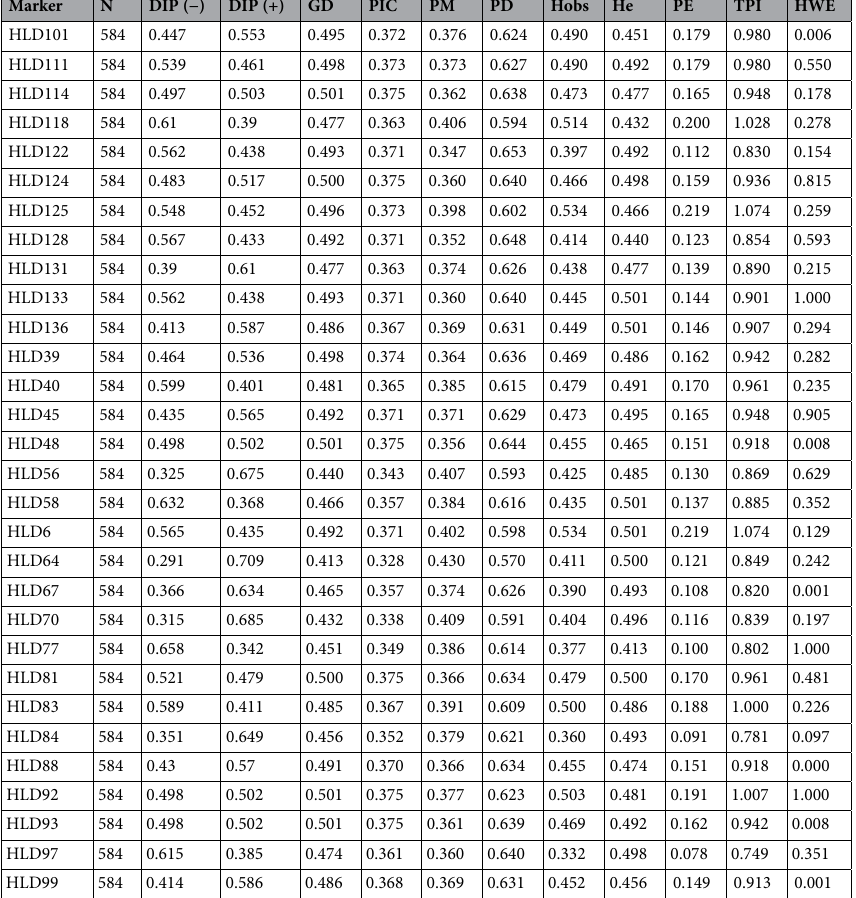
Table 1. Allele frequencies and forensic parameters of 30 loci in 293 Bahrainis. N, number of samples; DIP( − ), deletion; DIP(+), insertion; GD, Gene diversity; PIC, Polymorphic information contents; PM, Matching probability; PD, Power of discrimination; Hobs, observed heterozygosity; He, Expected heterozygosity; PE, Power of exclusion; TPI, typical paternity index; HWE, Hardy–Weinberg